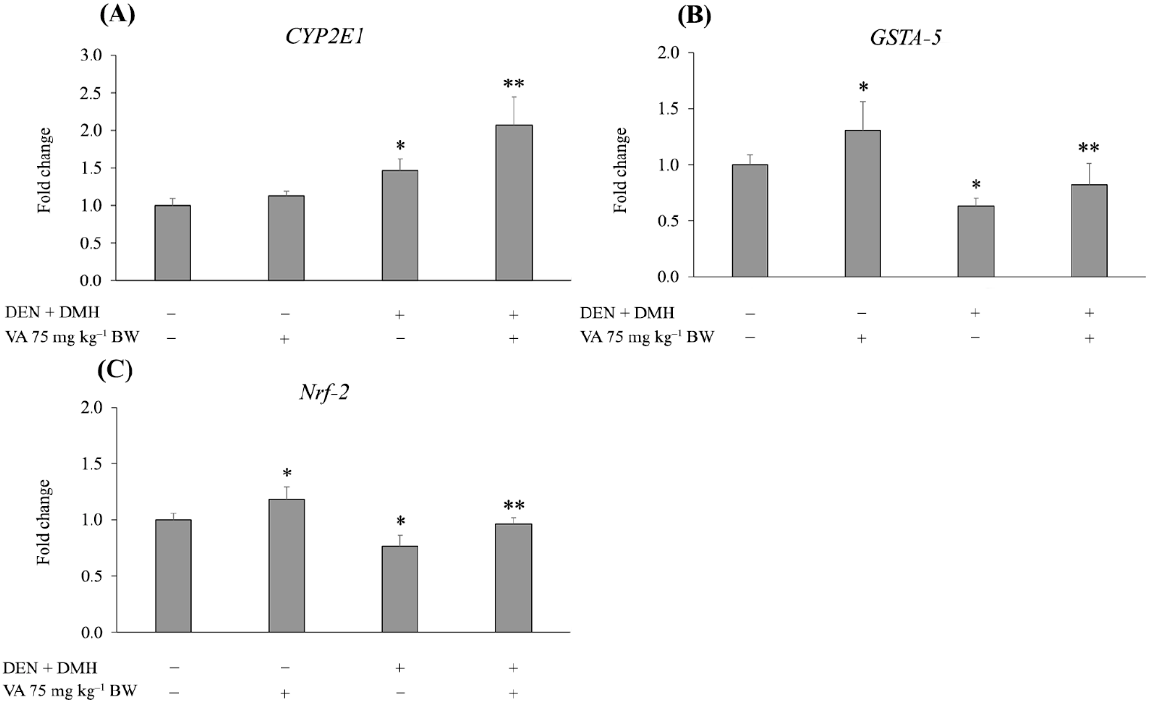
Figure 3. The effect of VA on the expression of genes of some Phase I and Phase II enzymes. ( A ) CYP2E1 : cytochrome P450 2E1. ( B ) GSTA-5 : glutathione S -transferase A5. ( C ) Nrf-2 : nuclear factor erythroid 2-related factor 2. Values are expressed as mean ± SD. * Significantly different from negative control group, p < 0.05. ** Significantly different from positive control group, p < 0.05. DEN: diethylnitrosamine, DMH: 1,2-dimethylhydrazine, NSS: normal saline solution, VA: vanillic acid.